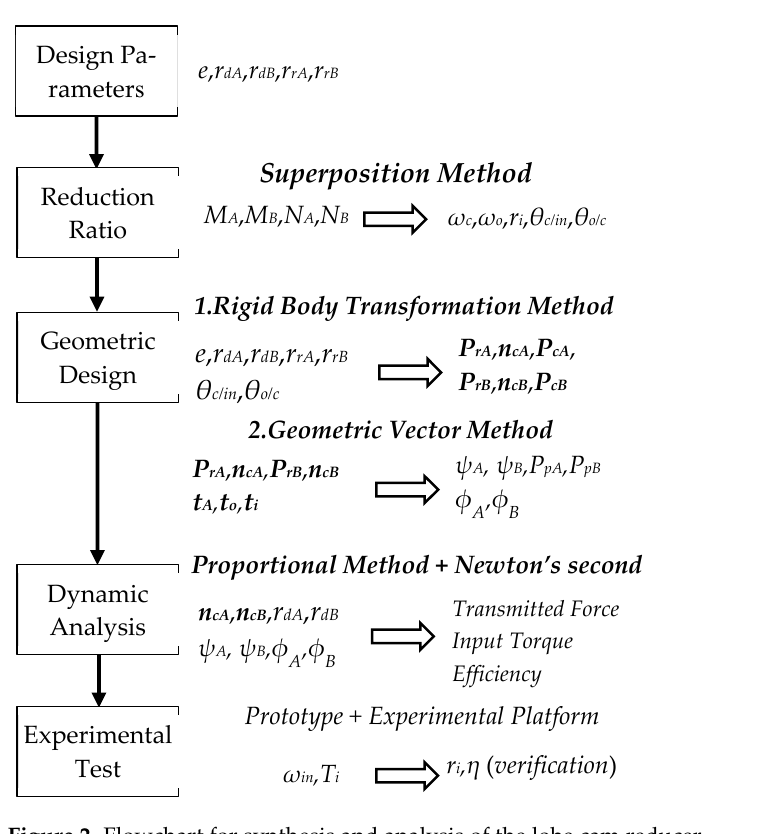
Figure 2. Flowchart for synthesis and analysis of the lobe cam reducer.